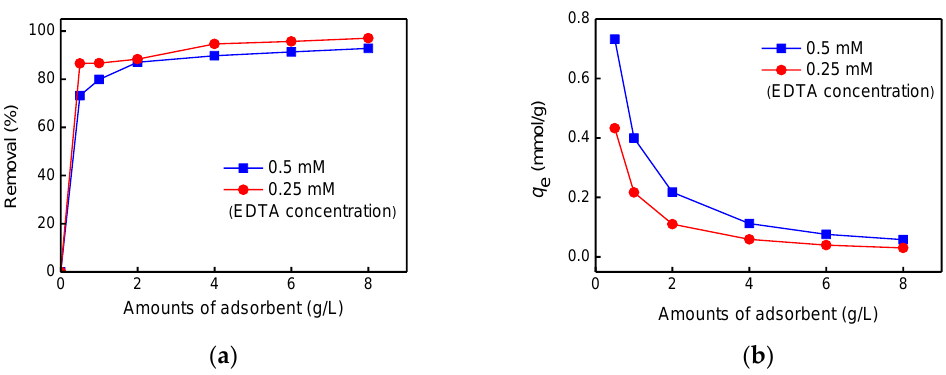
Figure 5 . Changes in ( a ) the removal efficiency of EDTA and ( b ) the adsorption capacity of AERs at EDTA concentrations of 0.25 and 0.5 mM (pH = 7; adsorption time = 5 h).